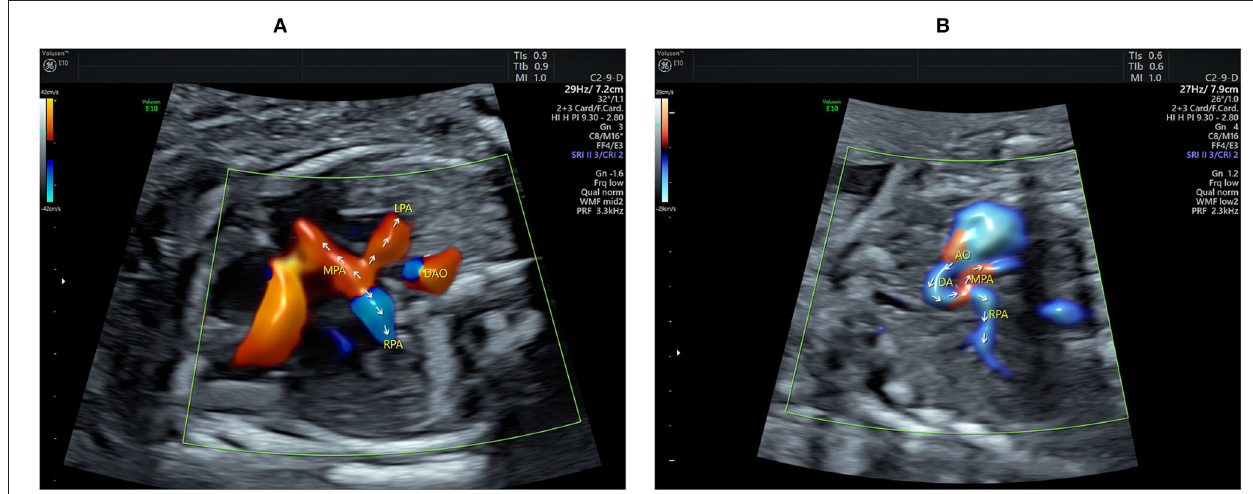
FIGURE 2 | Echocardiograms showing the main pulmonary artery (MPA) with its branching and the aberrant ductus arteriosus (DA). (A) The Color flow mapping shows the antegrade flow in both the LPA and RPA together with the retrograde flow in the distal MPA (indicated by arrows). (B) The course and the direction of the blood flow (indicated by arrows) in the DA are clearly shown when using HDFI in a parasagittal view. AO, aorta; DA, ductus arteriosus; DAO, descending aorta; LPA, left pulmonary artery; MPA, main pulmonary artery; RPA, right pulmonary